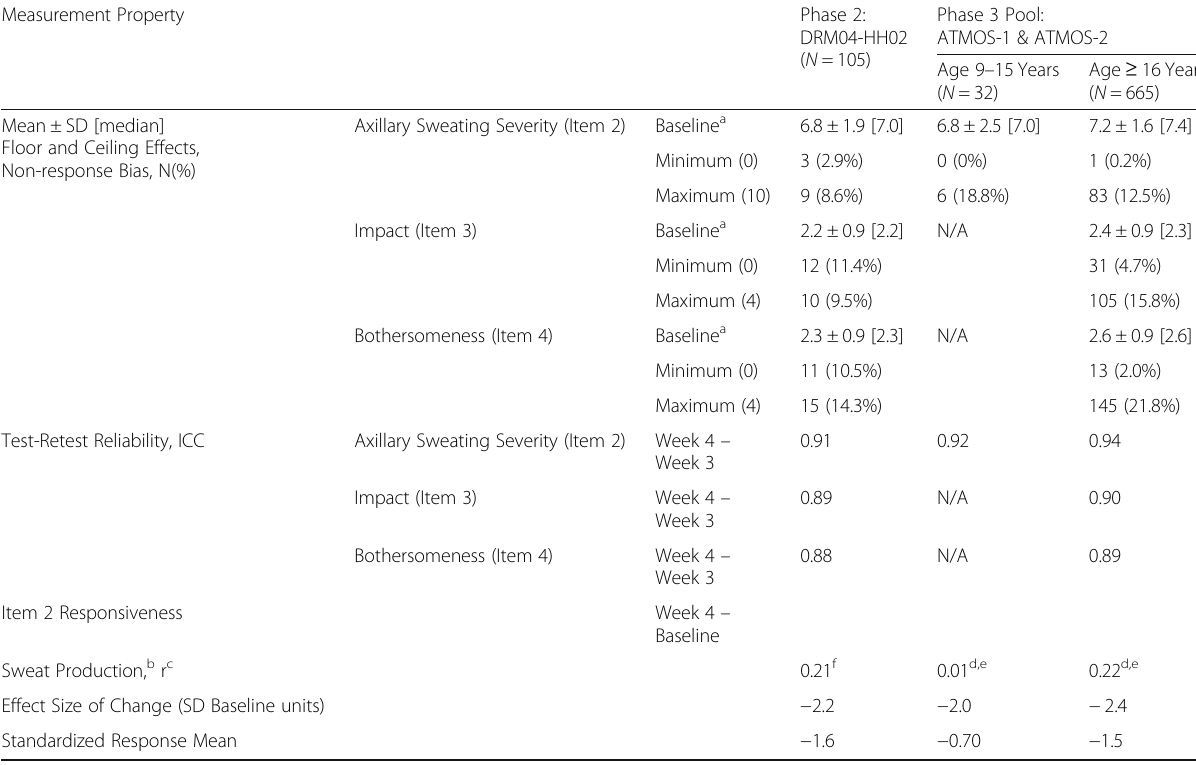
Table 4 ASDD/ASDD-C Measurement Properties Evaluated in Phase 2 and Phase 3 Trials Measurement